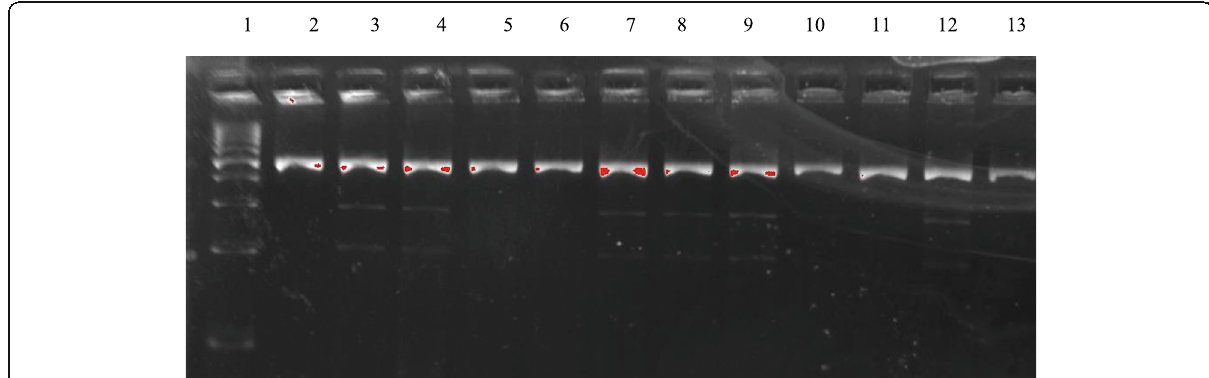
Fig. 3 Gel image of VDR gene TaqI polymorphism PCR-RFLP products. Lane 1: Molecular size marker (100 bp, Vivantis). lanes 2, 5, 6, 10, 11,13: TT wild- type homozygosis produces fragments of 495 bp. lanes 3, 4, 7, 8, 9,12: Tt heterozygosis produces fragments of 495, 290, and 205